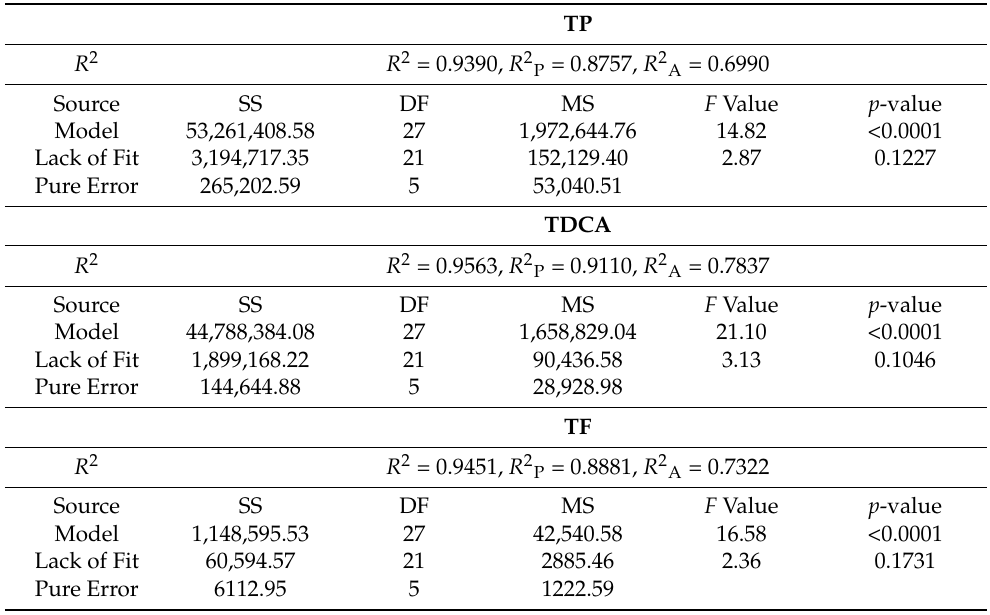
Table 3. Analysis of variance (ANOVA) and coefficients of determination ( R 2 ) for the fitted model equations of contents of total phenols (TP), dihydroxycinnamic acids (TDCA), flavonoids